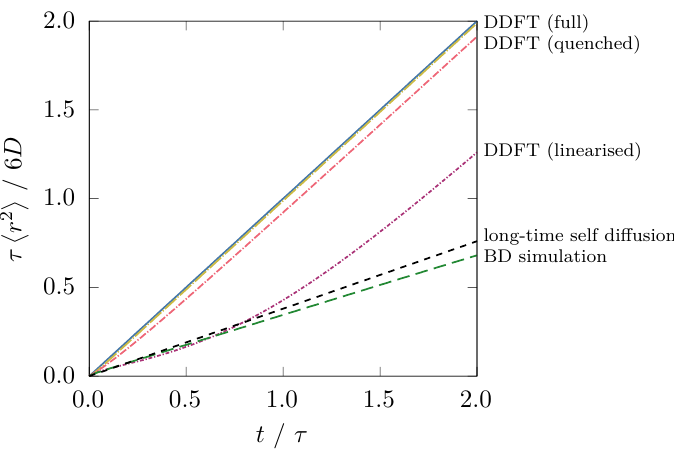
(cid:10) (cid:11) τ/ r 2 Figure 3: Mean square displacement 6 D as a function of time t /τ of the self component of the van Hove function. Data is shown from BD simulation (green long dashes) and from DDFT with the full (yellow long dot-dashes), quenched (red medium dot-dashes) and partially linearised (purple short dot-dashes) excess free energy functional. Additionally, we show the long-time self diffusion (black short dashes) as calculated from our PFT approximation (57). As a reference, the linear law of ideal diffusion (blue solid line) is also